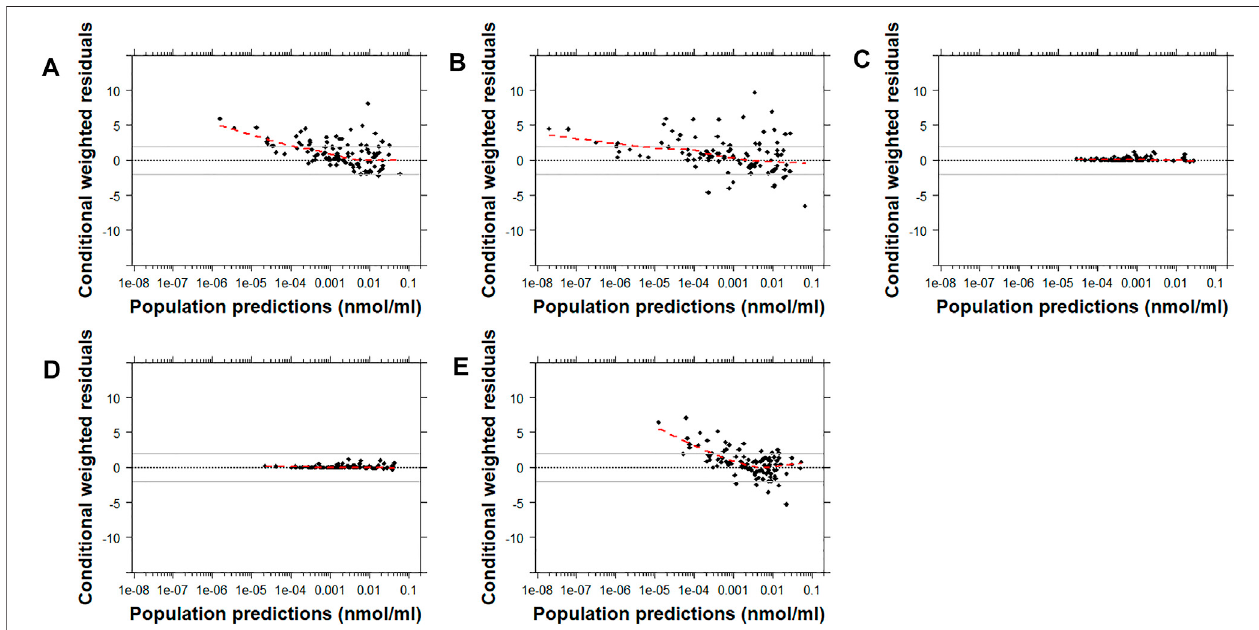
FIGURE 4 | Conditional weighted residuals (CWRES) versus population predictions for risperidone plotted on a log scale. Model (A) : Kloosterboer et al., 2021; Model (B) :Sherwin etal.,2012;Model (C) :Fenget al.,2008;Model (D) : Fenget al.,2008withallometricscaling; and Model (E) :Thyssenetal.,2010.Thedashed black linecorrespondstoaCWRESofzero.ThesolidgreylinescorrespondtoCWRESvaluesof2and − 2.Thedashedredlinecorrespondstothelocally-weightedscatterplot smoothing curve (LOWESS).